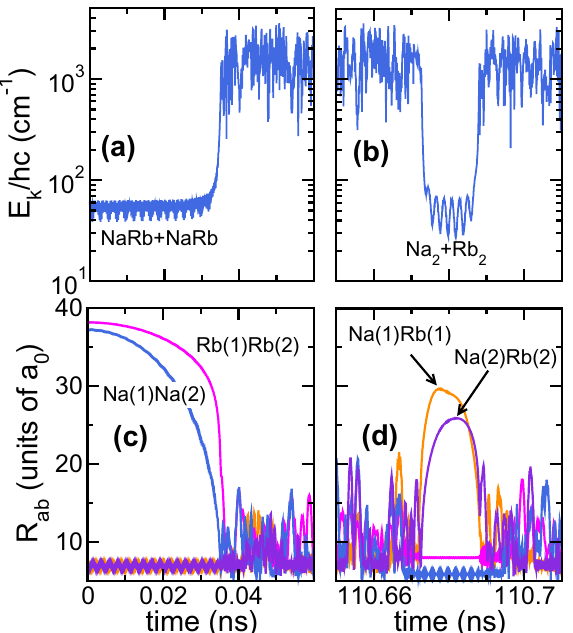
Figure 3. Total kinetic energy, E k , and interatomic separations, R ab , as functions of time for a zero-impact- parameter trajectory with a lifetime of 200 ns. Panel ( a ) shows E k for the first 0.06 ns of the association of two NaRb into a tetramer complex. Panel ( b ) shows a roaming event that occurs 110.66 ns into the collision. Panels ( c ) and ( d ) show the relevant pair separations between the Na and Rb atoms as functions of time for the time intervals in panels ( a ) and ( b ), respectively. Only pair separations with the largest values have been labeled. The line colors in the two panels have the same meaning. Here, roaming leads to the temporary formation of homonuclear Na 2 and Rb 2 . Figures were prepared using Grace-5.1.22 software.